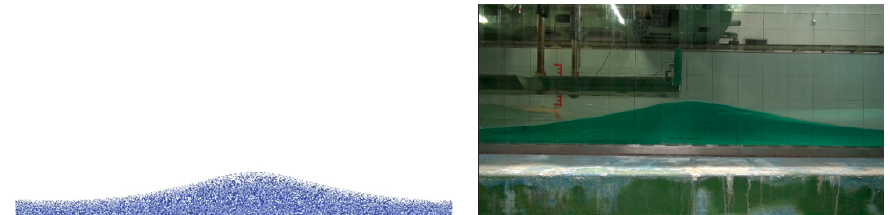
Figure 10. Comparison of wave surface profile for t = 38.2 s and 38.8 s with A = 50.5 mm, T = 1.15 s and d = 0.4 m.